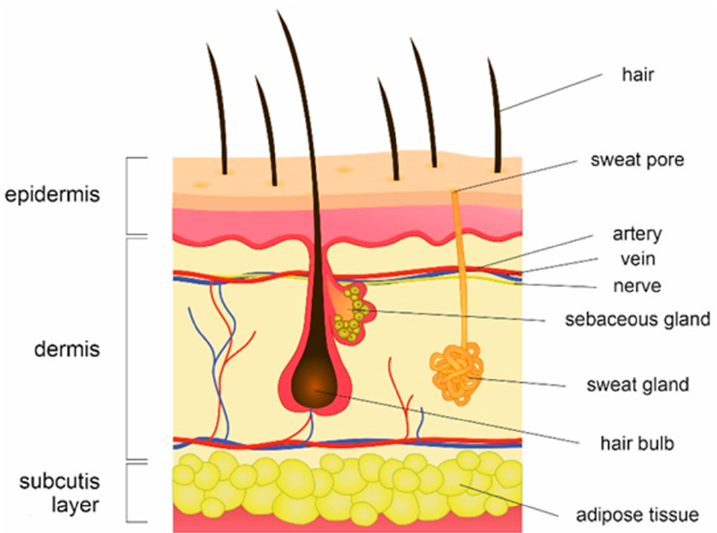
Figure 1. Schematic representation of human skin structure consisting of three main layers: epidermis, dermis and subcutis. The outermost skin layer, epidermis, is composed of terminally differentiated keratinocytes that enable continuous skin renewing, held together by corneodesmosomes and mortar lipids. Epidermis is supported by the collagen-bound dermis that provides a home for nerves, blood, lymph vessels, mast cells and other structures (i.e., sweat glands, hair follicles), and subcutis consisting of adipose tissue. Skin regions vary in terms of topography, temperature, salt content and acidity (pH) and are, based on their features, categorized into three major groups: moist sebaceous and dry.